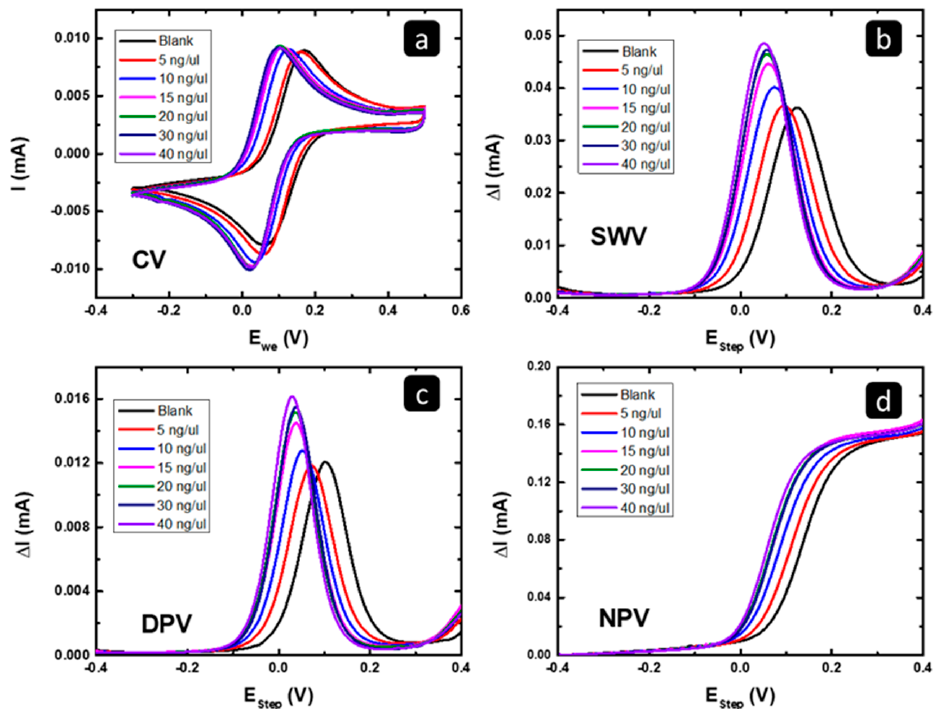
Figure 4. The electrochemical responses of Au-SPE before and after depositing different amounts of the MCF7 exosomal RNA using ( a ) CV, ( b ) SWV, ( c ) DPV, and ( d ) NPV techniques. The peak potential change was tracked versus the concentration of the exosomal MCF 7 RNA for the four techniques and presented in Figure 5, using a concentration range of 0–40 ng/uL. Figure 5 shows that the peak potential shifts to less positive values signifi- cantly and linearly with the exosomal RNA concentration up to 20 ng/ µ L, and then reaches a plateau, indicating the insignificant change in peak potential with increasing concen- tration. This behavior should be related to the surface saturation with exosomal RNAs, and hence, a further increase in the exosomal RNAs concentration will not lead to further adsorption of these exosomal